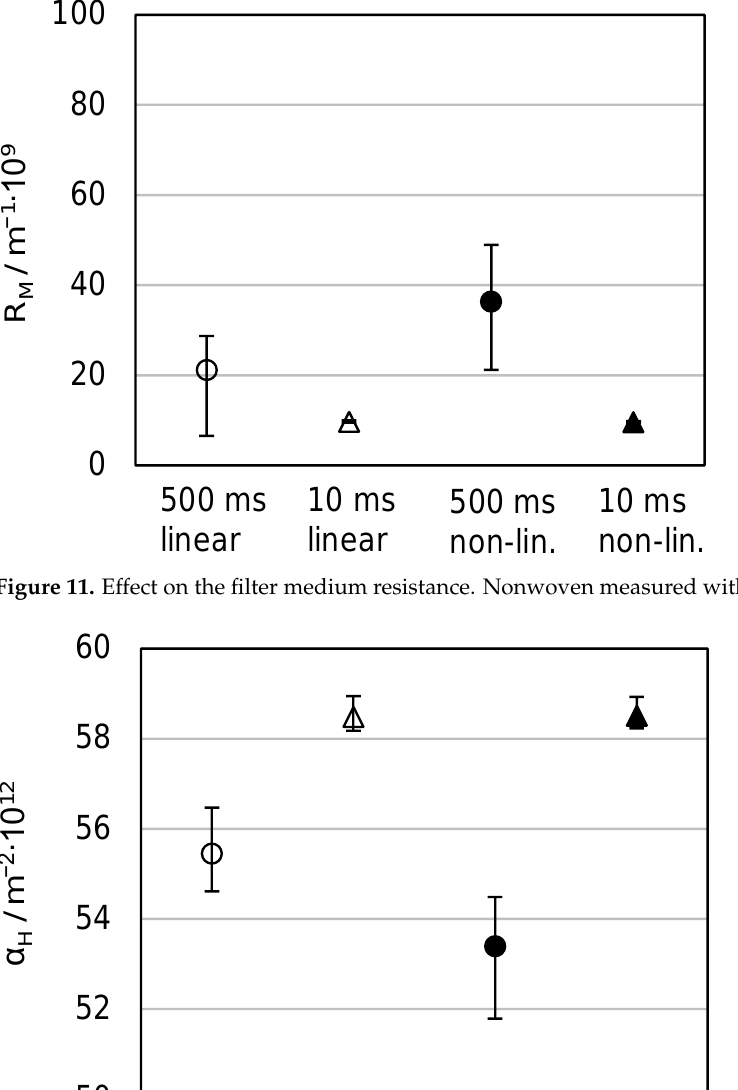
Figure 12. Effect on the filter cake resistance. Nonwoven measured with 25 m% PCC at 0.8 bar. In addition to smaller deviations between the measurements, which are reflected in smaller error bars, the influence of the determination method also became clear. For filtration measurements with high resolution the type of evaluation has been shown to play no role. The differences in the final result between the standard linear method and the nonlinear regression according to Kuhn et al. are negligible. In the filtration tests with the standard laboratory balance only pairs of values in the t/V-V diagram above a volume value of 20 mL were considered for the linear determination method. In contrast, all measured values from the beginning to the end of filtration were considered for the non- linear evaluation. As can be clearly seen in Figures 11 and 12 the exclusive consideration of the linear values even leads to a better approximation to the measurement result with the rapid balance compared to the nonlinear evaluation. The same effects can also be observed when determining the filter cake and filter medium resistance for the multifilament fabric (Figures 13 and